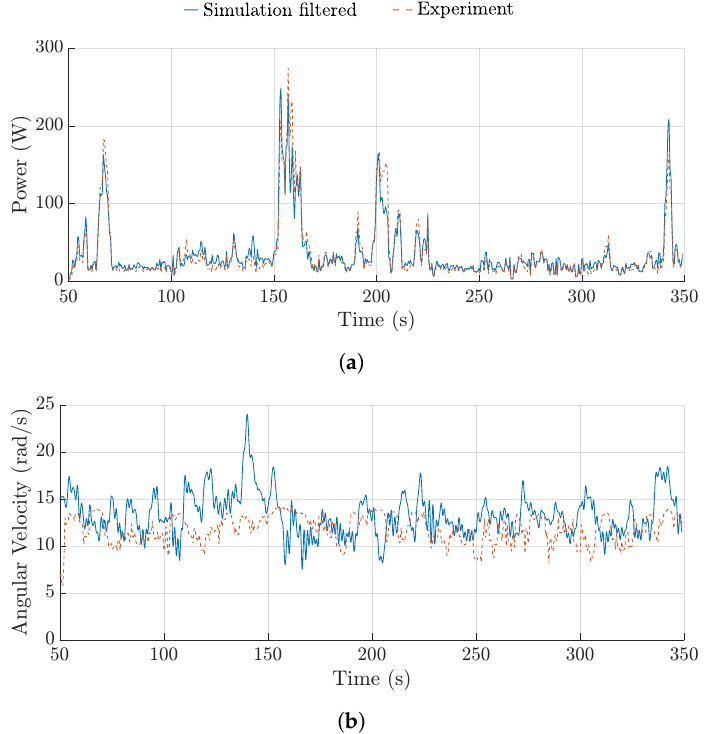
Figure 13. Comparison between the spring-disc model with a low pass filter and experimental data. ( a ) Power output comparison; ( b ) Angular velocity